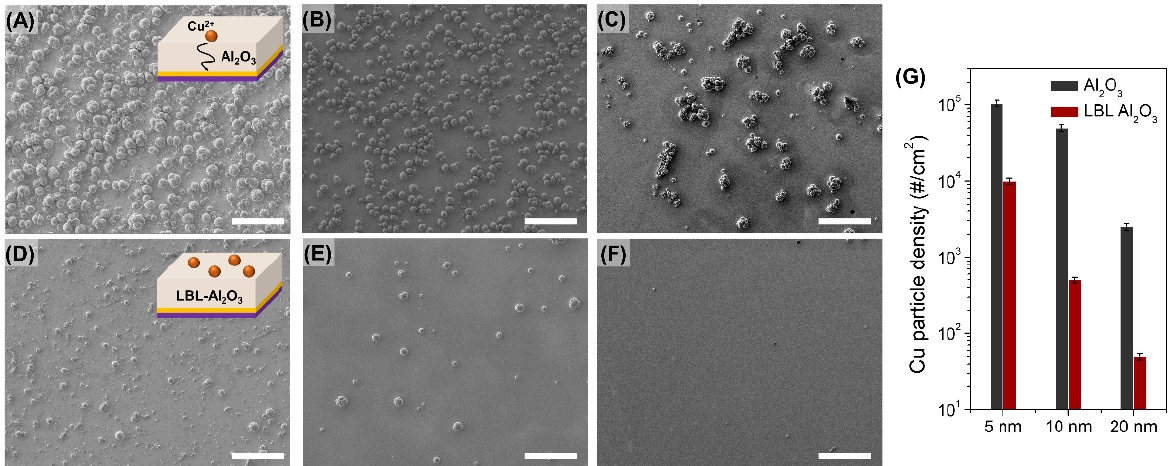
Figure 3. Electro-deposition of Cu particle on barrier bare Al 2 O 3 ( A ) 5 nm ( B ) 10 nm ( C ) 20 nm and LBL Al 2 O 3 ( D ) 5nm ( E ) 10 nm ( F ) 20 nm (Scale bar is 10 μ m) ( G ) Comparison graph of Cu particle density between bare Al 2 O 3 and LBL templated Al 2 O 3 depends on thickness.